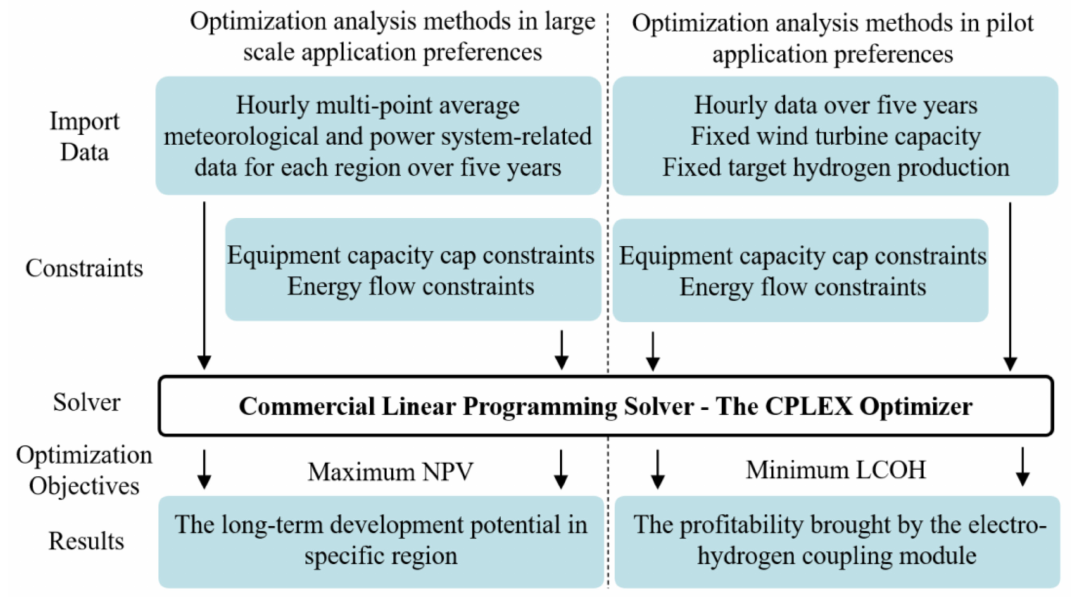
Figure 3. Flowchart of the optimisation